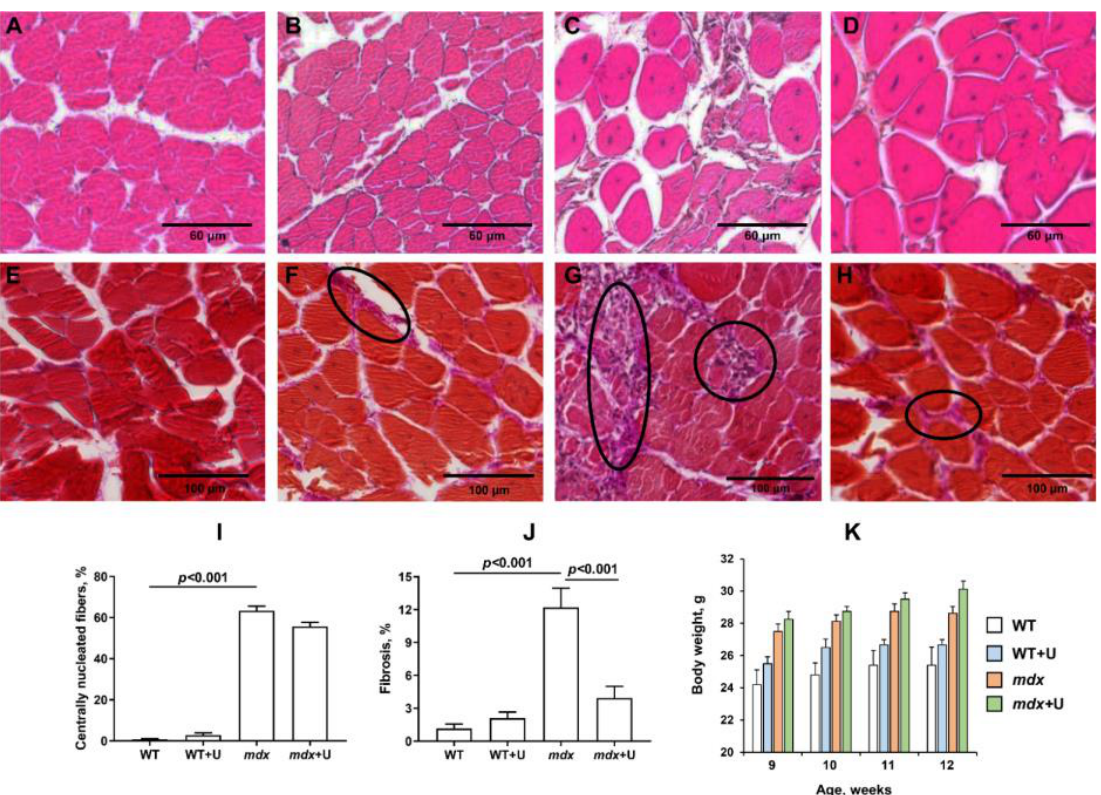
Figure 3. Representative histology images of skeletal muscle tissue (quadriceps) showing myofibers containing the centrally located nuclei ( A – D ) and fibrotic area ( E – H , outlined in black ovals) in the WT ( A , E ), WT+U ( B , F ), mdx ( C , G ), and mdx +U ( D , H ) groups of mice. The bars are equal to 60 μ m ( A – D ) and 100 μ m ( E – H ). Diagrams ( I ) and ( J ) show the percentage of myofibers containing centrally located nuclei and the amount of interstitial fibrosis in the skeletal muscles of animals. The data are presented as means ± SEM ( n = 5). The level of fibrosis was evaluated as the percentage ratio of the haematoxylin van Gieson (HvG) staining areas (pink) that represented collagen and other connective tissue elements in the common area of the tissue, wherein at least 10 sections were analyzed for each sample. Quantitative data of centrally nucleated fibers that underwent H&E staining are from, on average, 8–10 unique visual fields from each animal, and they are expressed as a percentage of the total number of myofibers counted. Panel ( K ) shows body weight gain in experimental groups of mice. The data are presented as means ± SEM ( n = 10).